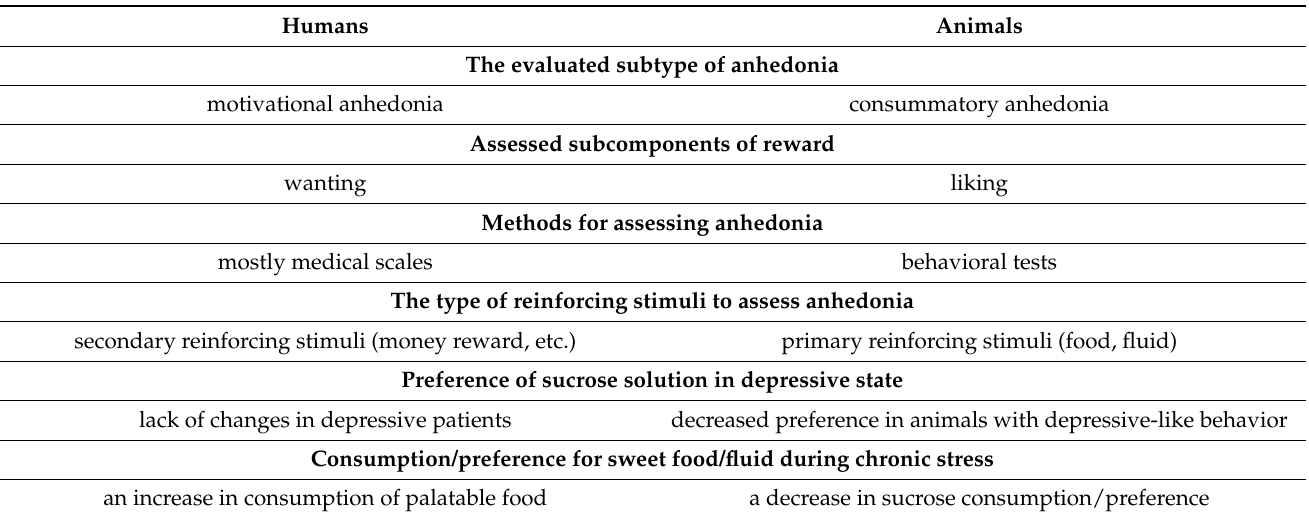
Table 1. Major differences between humans and animals related to